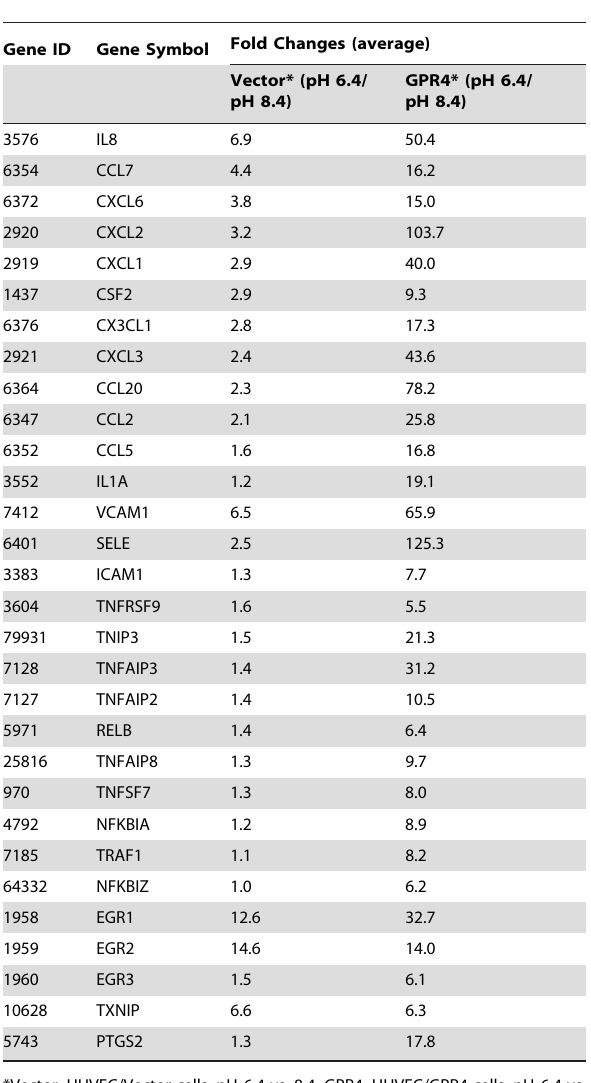
Table 1. A partial list of acidosis/GPR4-induced inflammatory genes by microarray